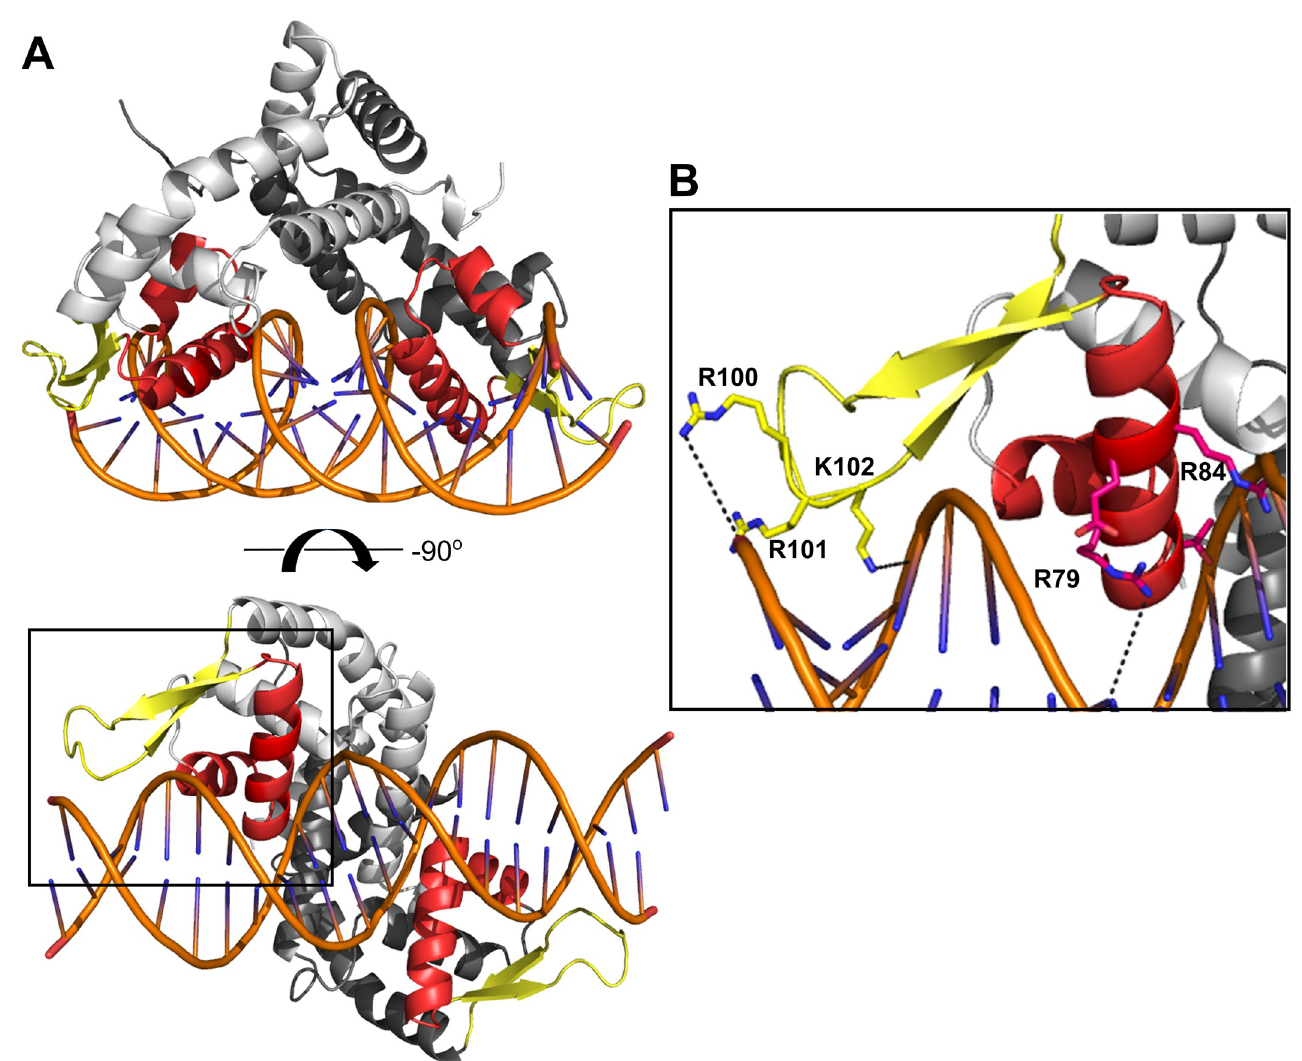
Fig 2. Model of BpsR bound to DNA. The model was created by superimposing the BpsR structure onto the structure of the Escherichia coli MarR-DNA complex (PDB ID: 5H3R [38]). The protein structures had an RMSD of 1.37 Å (A) This model shows how the recognition helix (red) of the wHtH domain inserts into the major groove of DNA. (B) A magnified section of the BpsR-DNA interaction highlights how the residues of the HTH domain interact with the phosphodiester backbone.